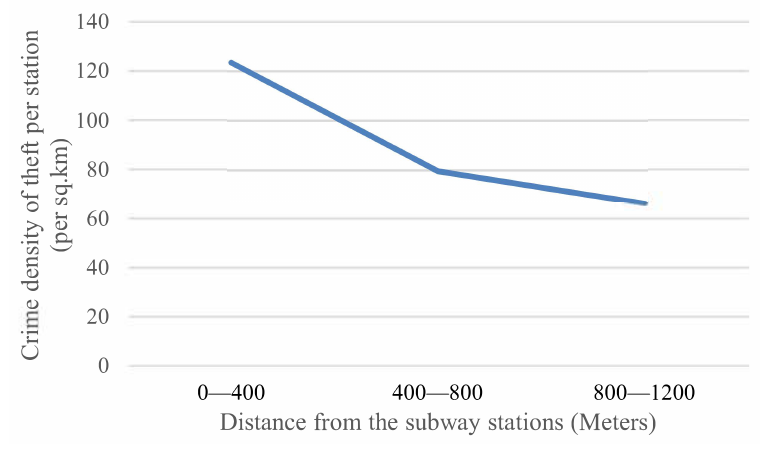
Figure 3. Distance decay of thefts around new subway stations.